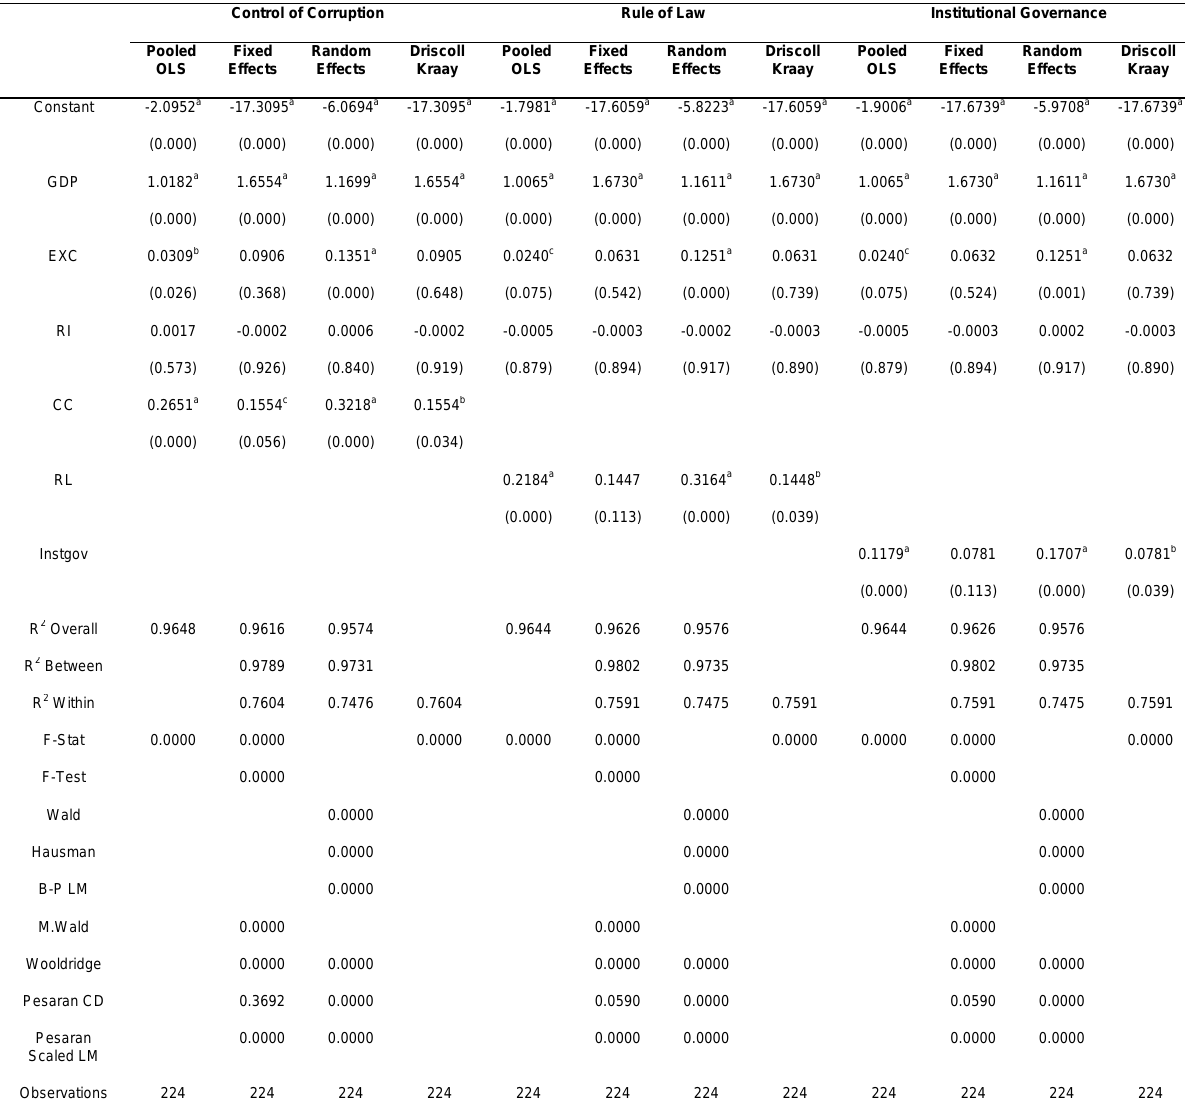
Table 3.6. Institutional Governance and Domestic Investment in